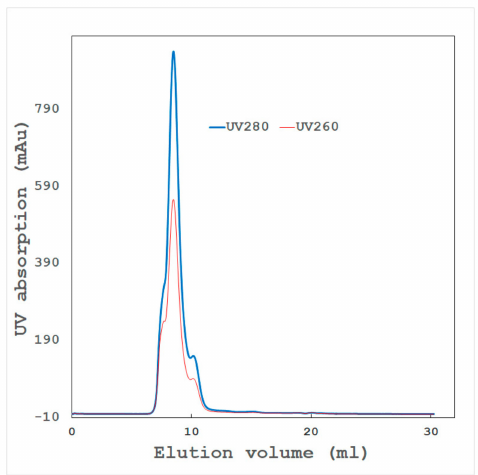
Figure 6. Typical chromatogram of gel filtration chromatography. A supramolecule protein with a molecular weight of 750,000 (pI = 5.8) was applied. Blue and red lines show the UV absorption of 280 and 260 nm, respectively. Proteins are separated with di ff erences in their molecular weights. Various size beads have been developed for each molecular weight. The leading and trailing shoulders of the main peak suggest the existence of di ff erent molecular weight components. After removing these components, the crystal quality was